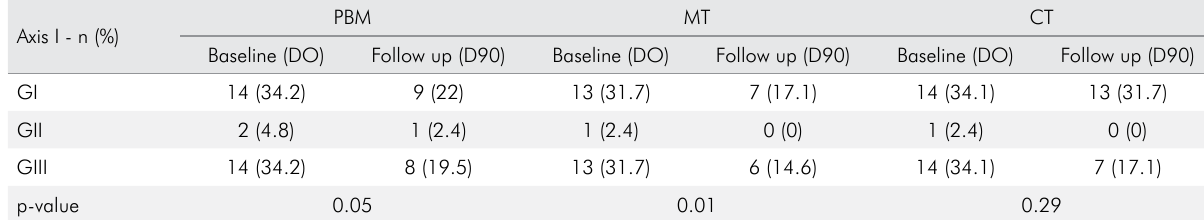
Table 2. RDC/TMD Axis I. Assessment of clinical TMD conditions before and after